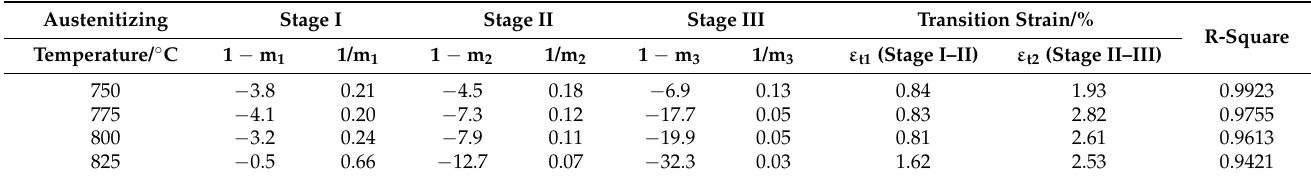
R-Square Tempera-